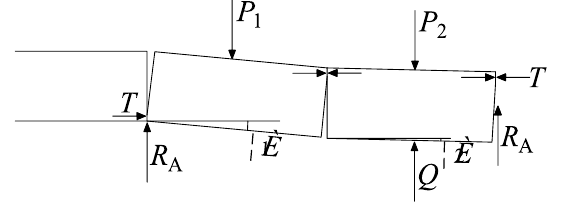
Figure 14. Masonry beam structural